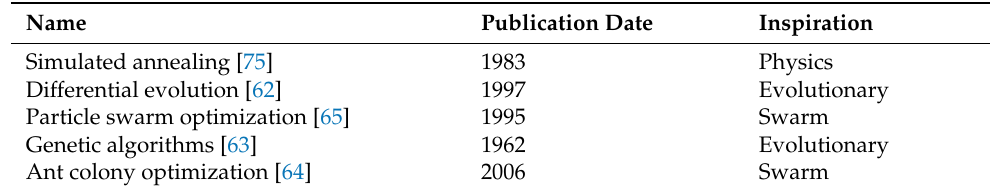
Table 1. Some most used